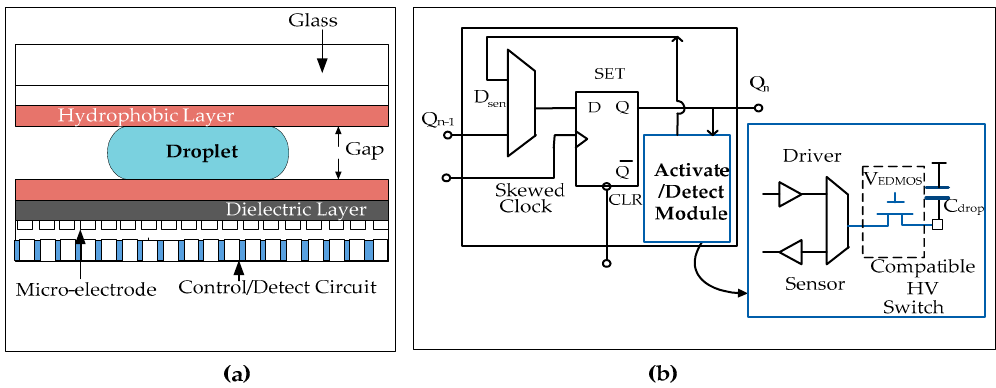
Figure 7. ( a ) MEDA architecture of biochip consisting of physical micro-electrode and the control circuitry underneath. ( b ) The detailed architecture of control and detect circuit beneath the micro- electrodes [10].